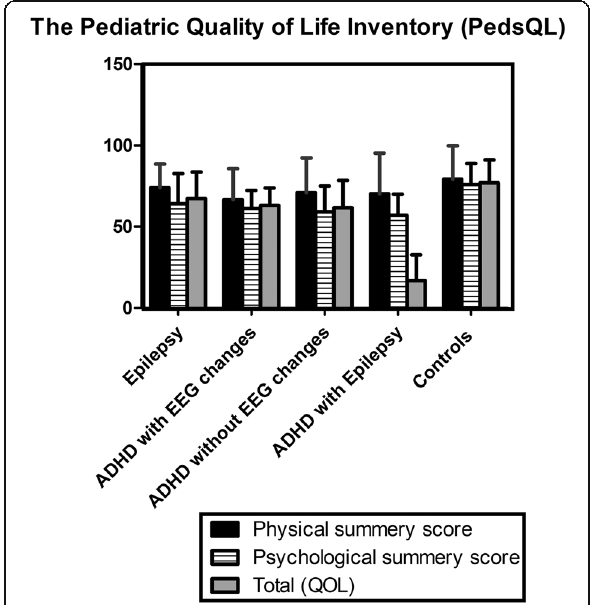
Fig. 2 The Pediatric Quality of Life Inventory (PedsQL) scores among the studied